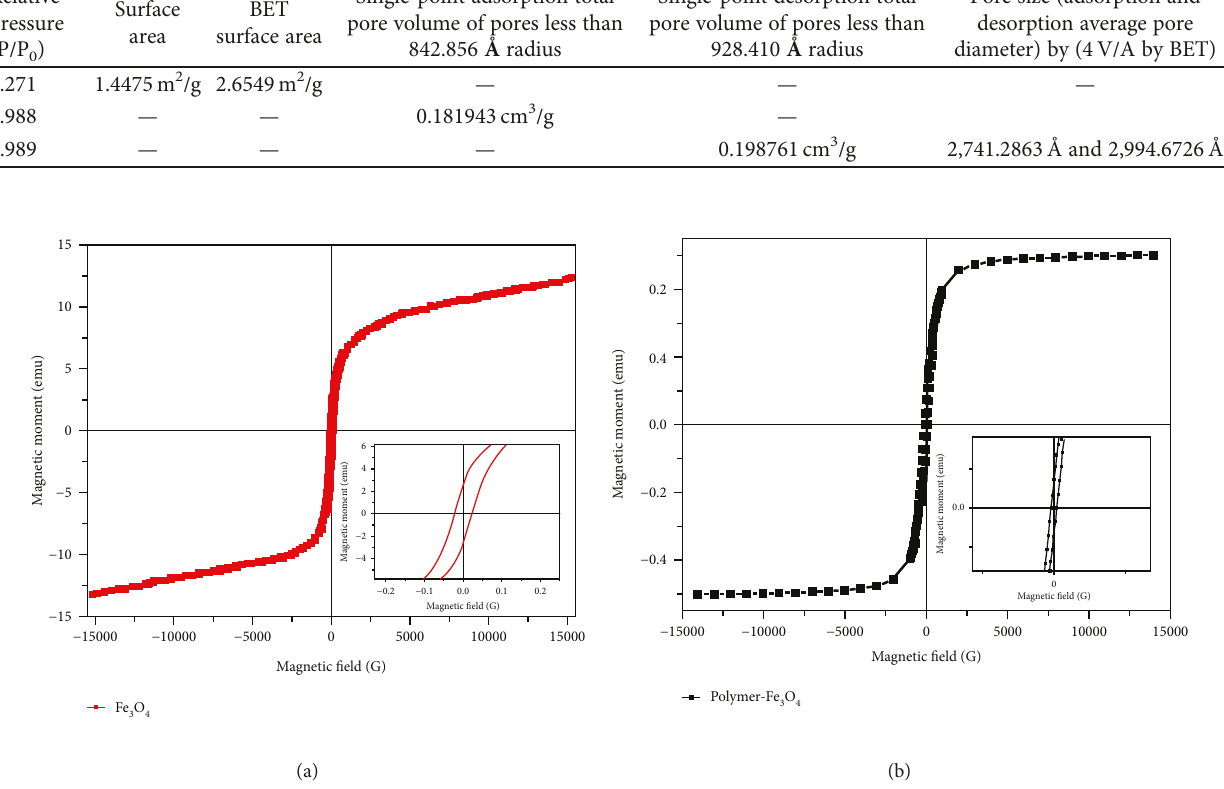
Figure 5: Comparison of the magnetic hysteresis loops of (a) pure iron oxide and (b) poly(4,4 ′ O composite. Fe 3 4